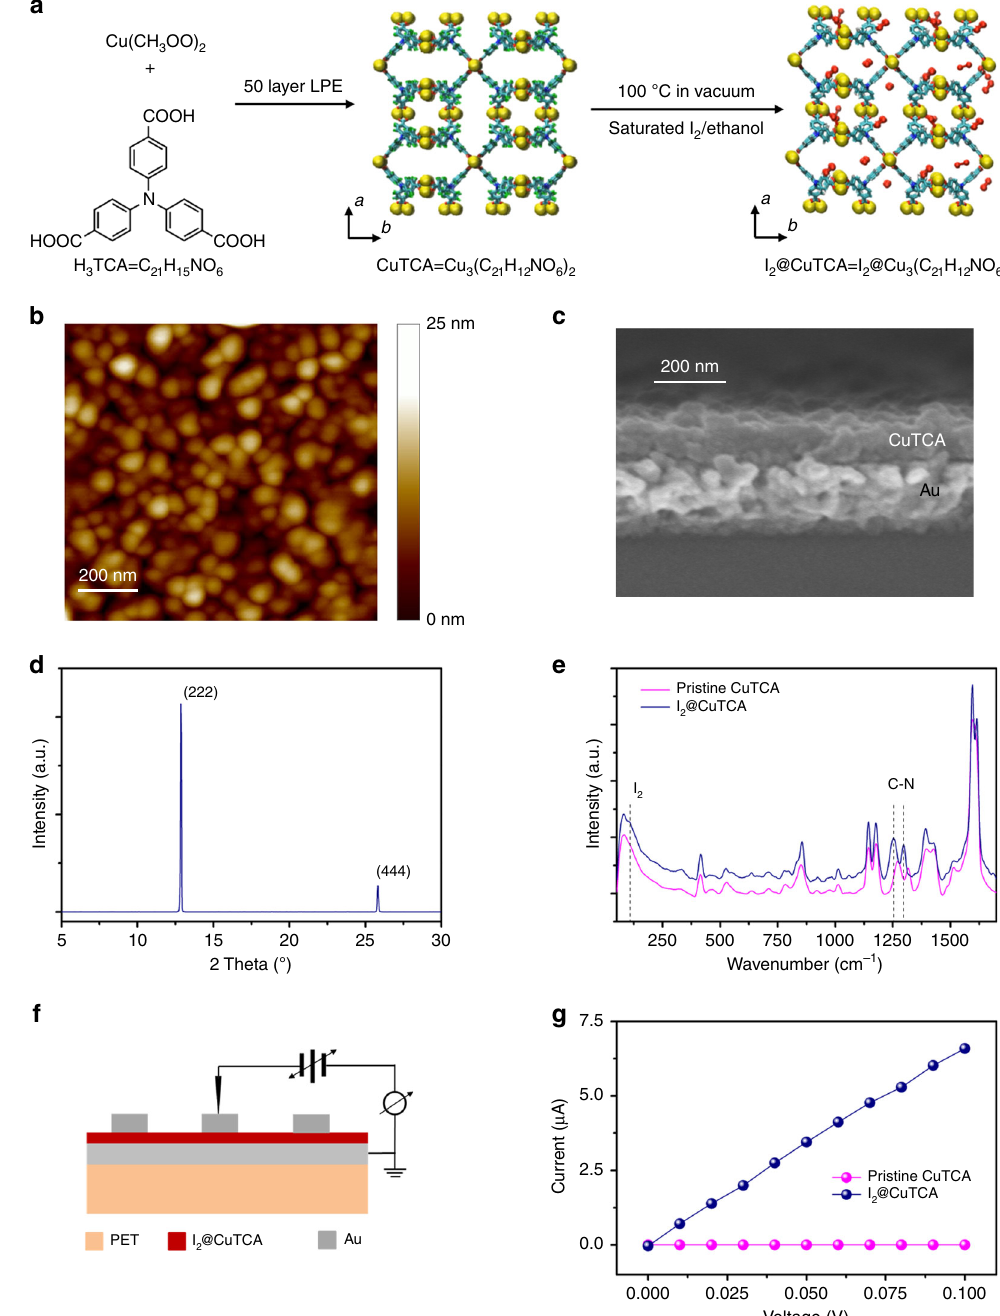
Fig. 1 Liquid-phase epitaxial synthesis (LPE) of CuTCA and I 2 @CuTCA nano fi lms. a Synthetic route of the metal – organic framework (MOF) nano fi lms. The chemical formula of H 3 TCA, CuTCA, and I 2 @CuTCA are C 21 H 15 NO 6 , Cu 3 (C 21 H 12 NO 6 ) 2 , and I 2 @ Cu 3 (C 21 H 12 NO 6 ) 2 , respectively. The cyan, white, blue, and red twigs represent carbon, hydrogen, nitrogen, and oxygen atoms, respectively. The yellow and red spheres stand for copper and iodine atoms, respectively. b Atomic force microscopic top-view image and c scanning electronic microscopic cross-section view image of the CuTCA nano fi lm deposited on Au/PET (polyethylene terephthalate) substrate. d X-ray diffractive pattern of the CuTCA nano fi lm. e Raman spectra of the pristine CuTCA and